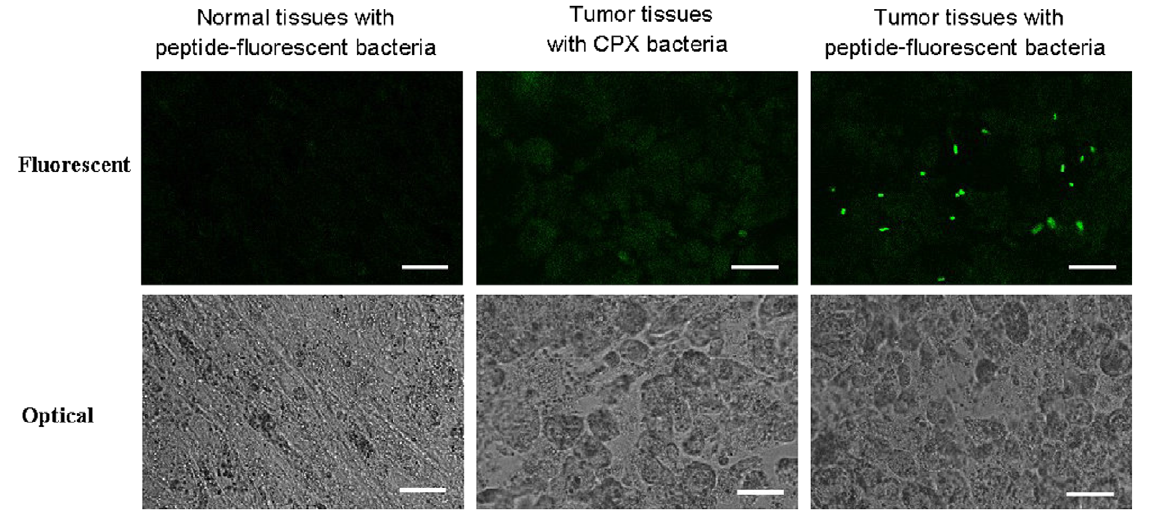
Figure 5. The representative images of selected peptide-fluorescent bacteria binding with tissue sections from the mice xenograft. The scale bar was 20 m m. Data were representative of at least three independent experiments.